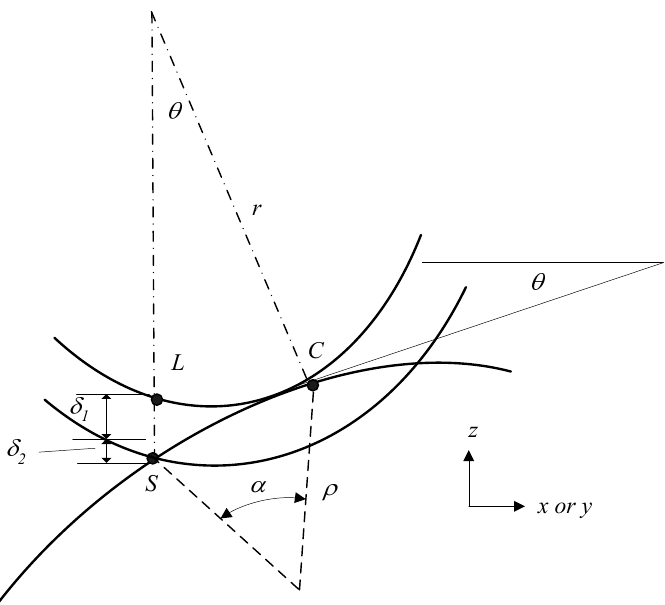
Figure 4. Interference of knife and designed surface.